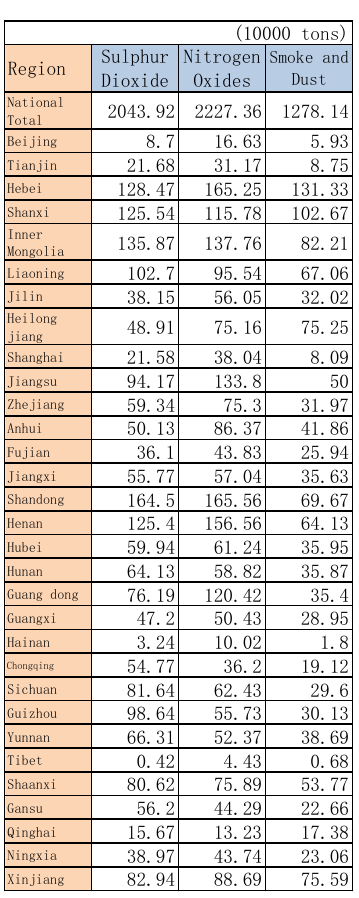
Figure A4. The main pollutant emissions in waste gas by region in China in